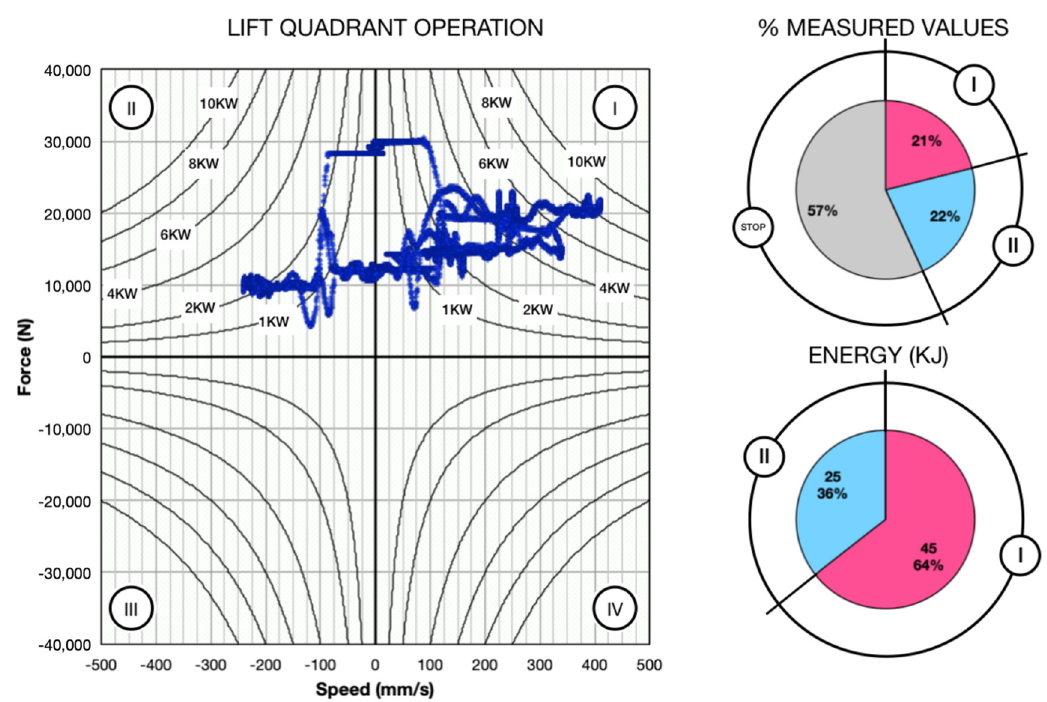
Figure 12. Quadrant operation of the lift actuator.